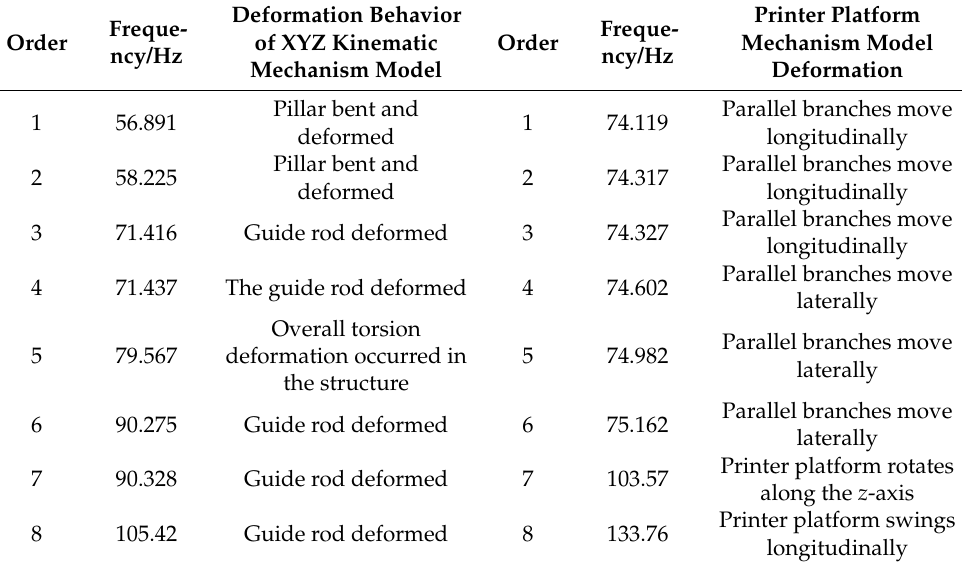
Table 1. Modal frequency and deformation of the moving